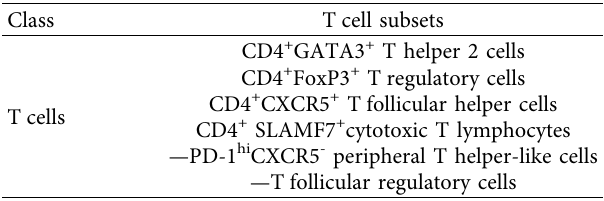
Table 2: Tcell subsets involved in the pathogenesis of IgG4-related